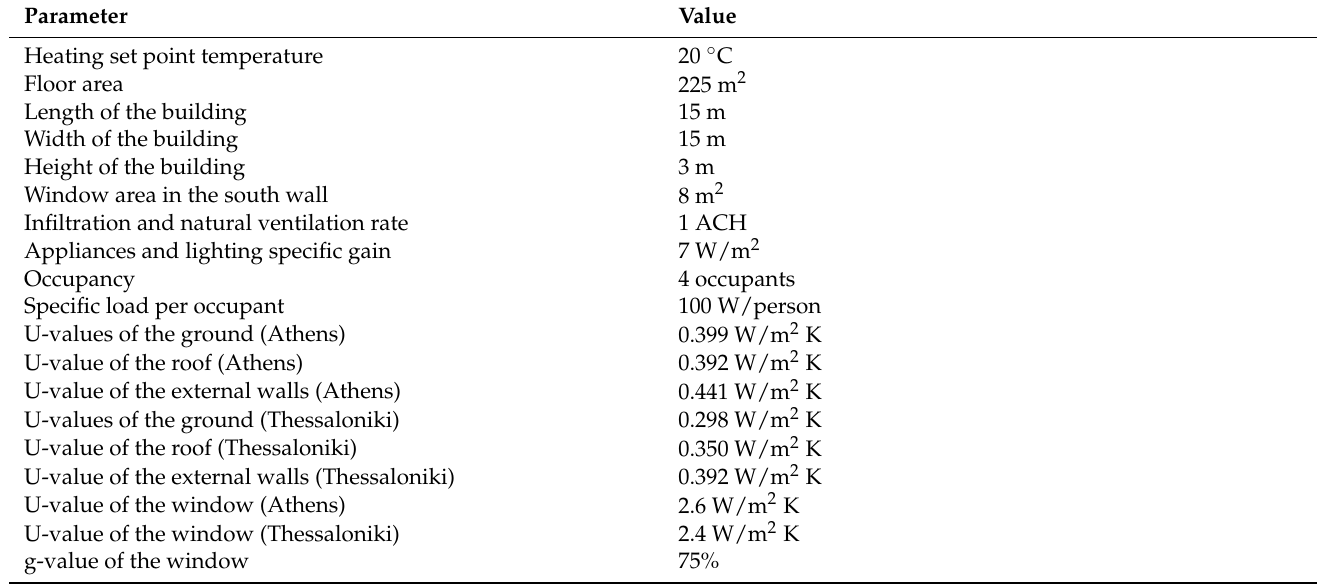
Table 3. Information for the examined